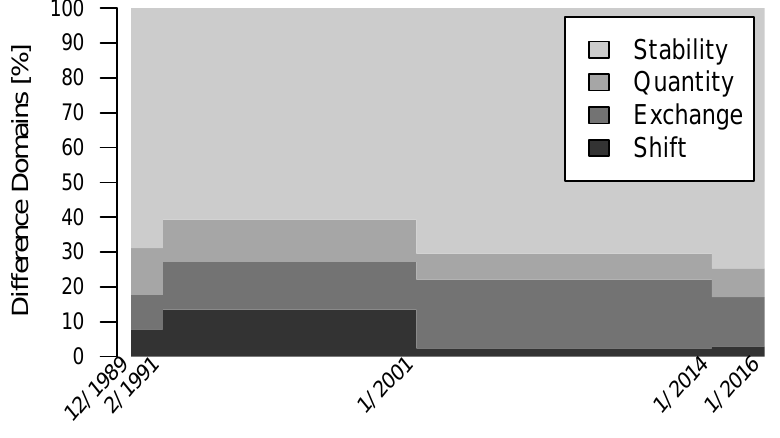
Figure 6. Share of three domains of change and stable conditions in relation to